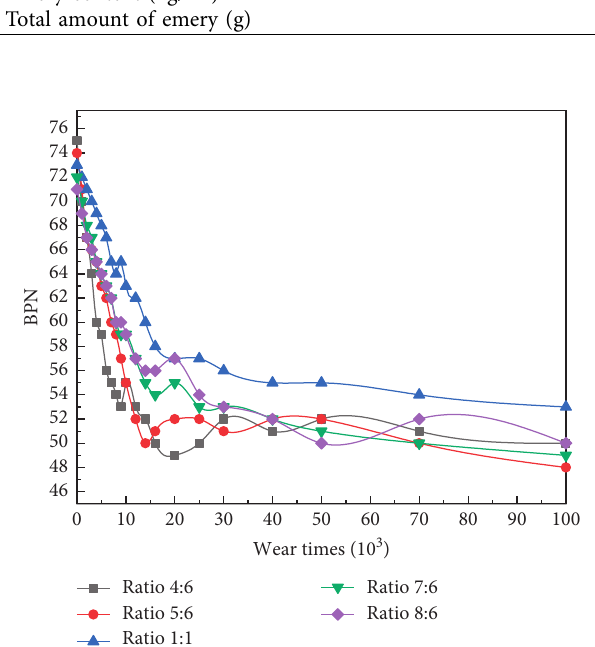
Table 11: The ratio of the amount of emery to the amount of epoxy emulsified asphalt and the amount of emery spreading in the skid resistance fog seal-test specimen. The ratio of emery content to epoxy emulsified asphalt